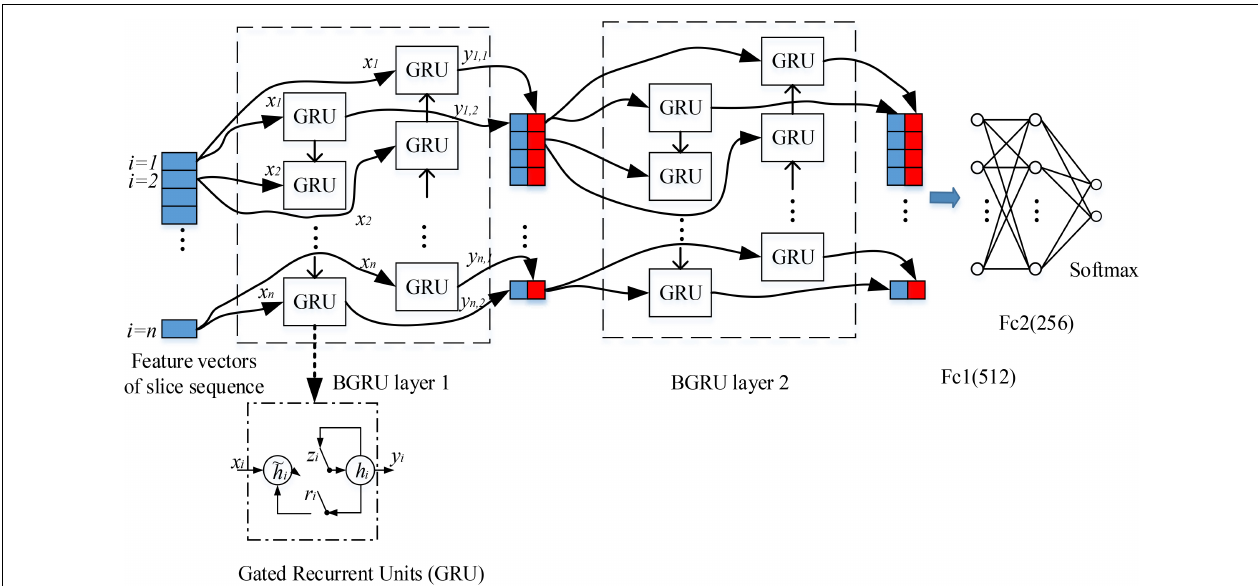
FIGURE 2 | Our deep recurrent neural network (RNN) based on two stacked layers of bidirectional gated recurrent units (BGRU), where xi are the feature vectors generated from image slice i as the inputs of BGRU while yi1 and yi2 are the output feature vectors of GRU from two directions (the internal structure of GRU is shown in the bottom, where ri„ zi, hi and hi are the reset gate, update gate, candidate hidden layer and output layer, respectively). On top of stacked BGRU layers, two fully connected layers and one softmax layer are appended for classification